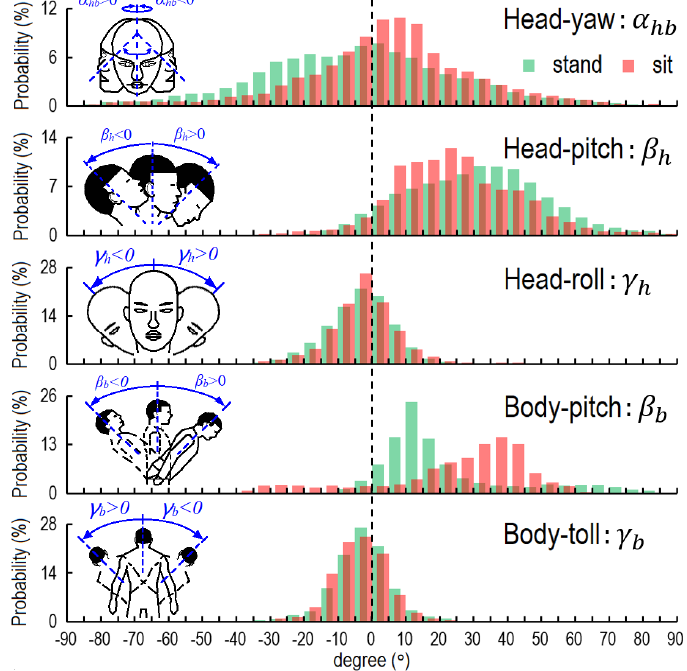
Figure 5. Probability distribution of head and body motions by posture.